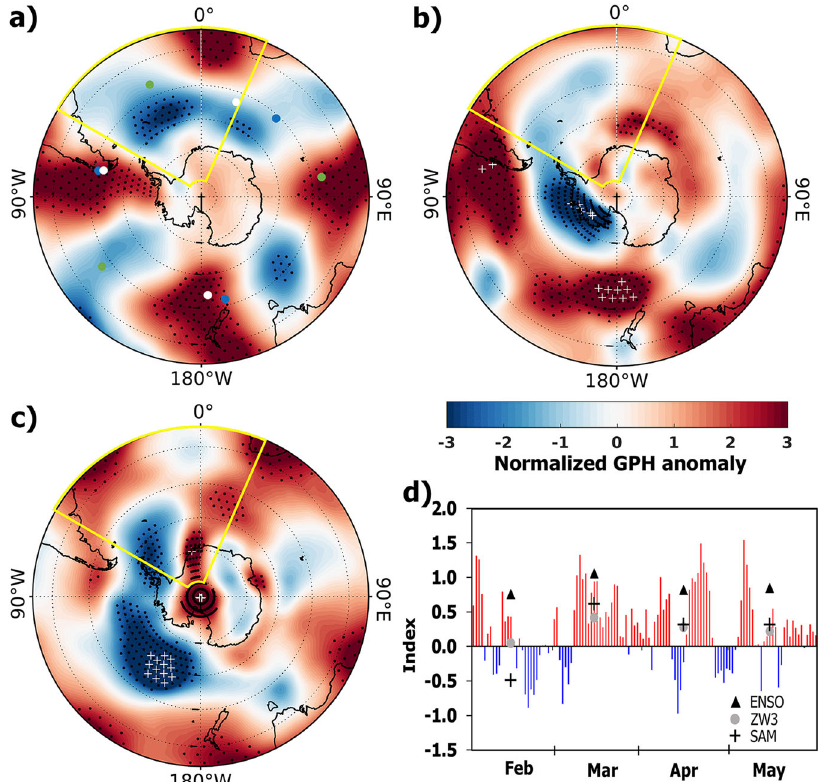
Fig. 8 Variability in zonal wave three (ZW3) index. Normalized anomalies of geopotential height at 500 hPa during ( a ) February ‒ March 2019, ( b ) April 2019 and ( c ) May 2019, relative to the climatology of 1979 – 2008. Black dot (plus) marks showed the values that exceeded 2 (4) standard deviation from the climatological mean. White dots marked in fi gure-a represent the locations used for computing amplitudes of ZW3 index in the present study (Methods section ‘ Atmospheric reanalysis ’ , Figure d). Locations used in the previous studies are shown in blue 14 and green 18 dots. Yellow box represents the Weddell Sea and surrounding region. d Daily changes in ZW3 index (red and blue bars) at three ridges (latitude 50.5°S; longitudes 18°E, 75°W, 172°E). Monthly mean SAM (plus marks) and ZW3 (circles) indices remained in positive phase, with a prevailing pattern of moderate El Niño events